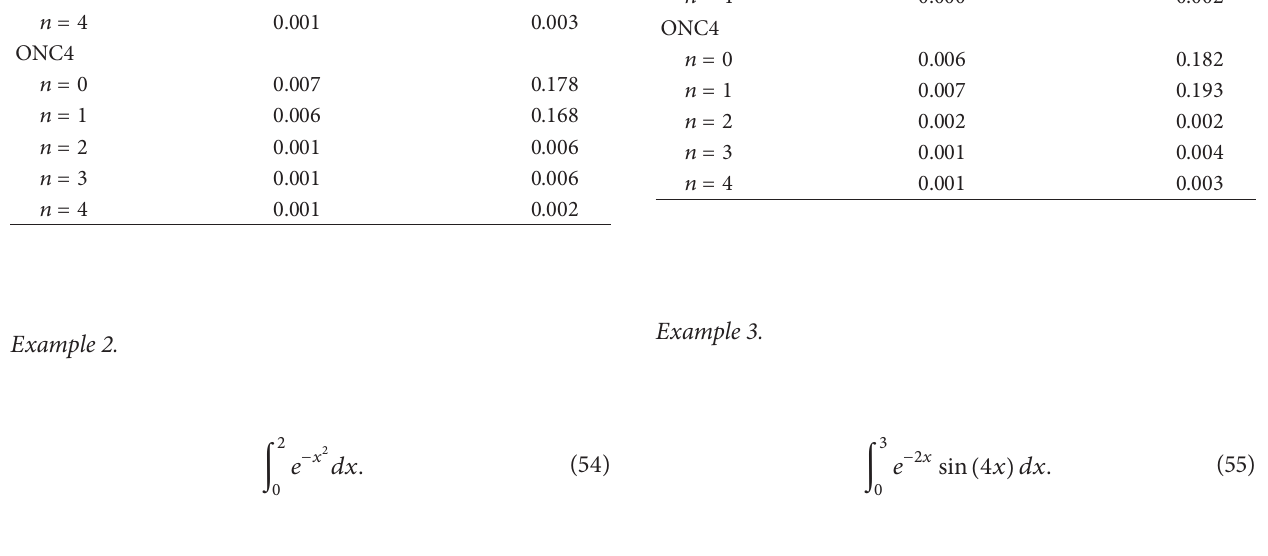
Table 10: Average CPU usage time for evaluating ∫